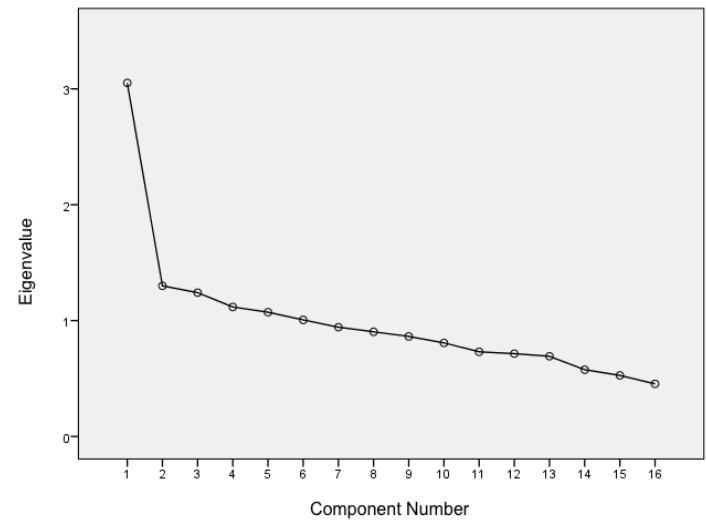
Figure 1. Scree Plot. Table 1. Reliability test of the questionnaire in the pilot test